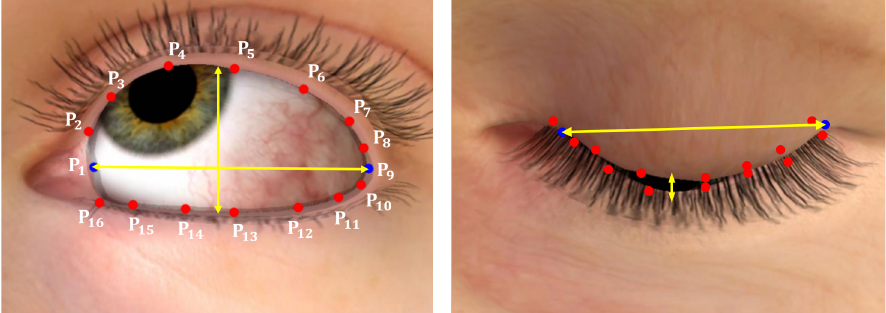
Figure 5. EAR was calculated through the displayed landmark coordinates (from P 1 to P 16 ). The blue dots are used to represent the width of the eye and the red the height. The eye on the right is in a state at which there is no need to estimate the